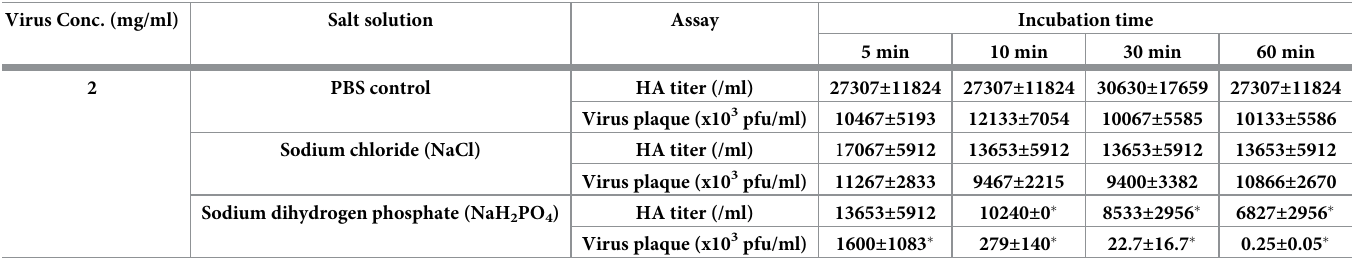
Table 2. Salt-mediated changes to viral HA activity and infectivity over time. Virus Conc.